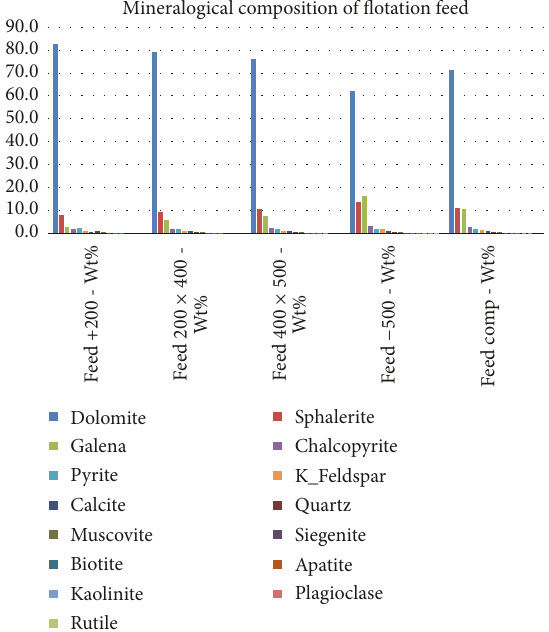
Figure 3: Mineralogical composition of flotation feed in different size